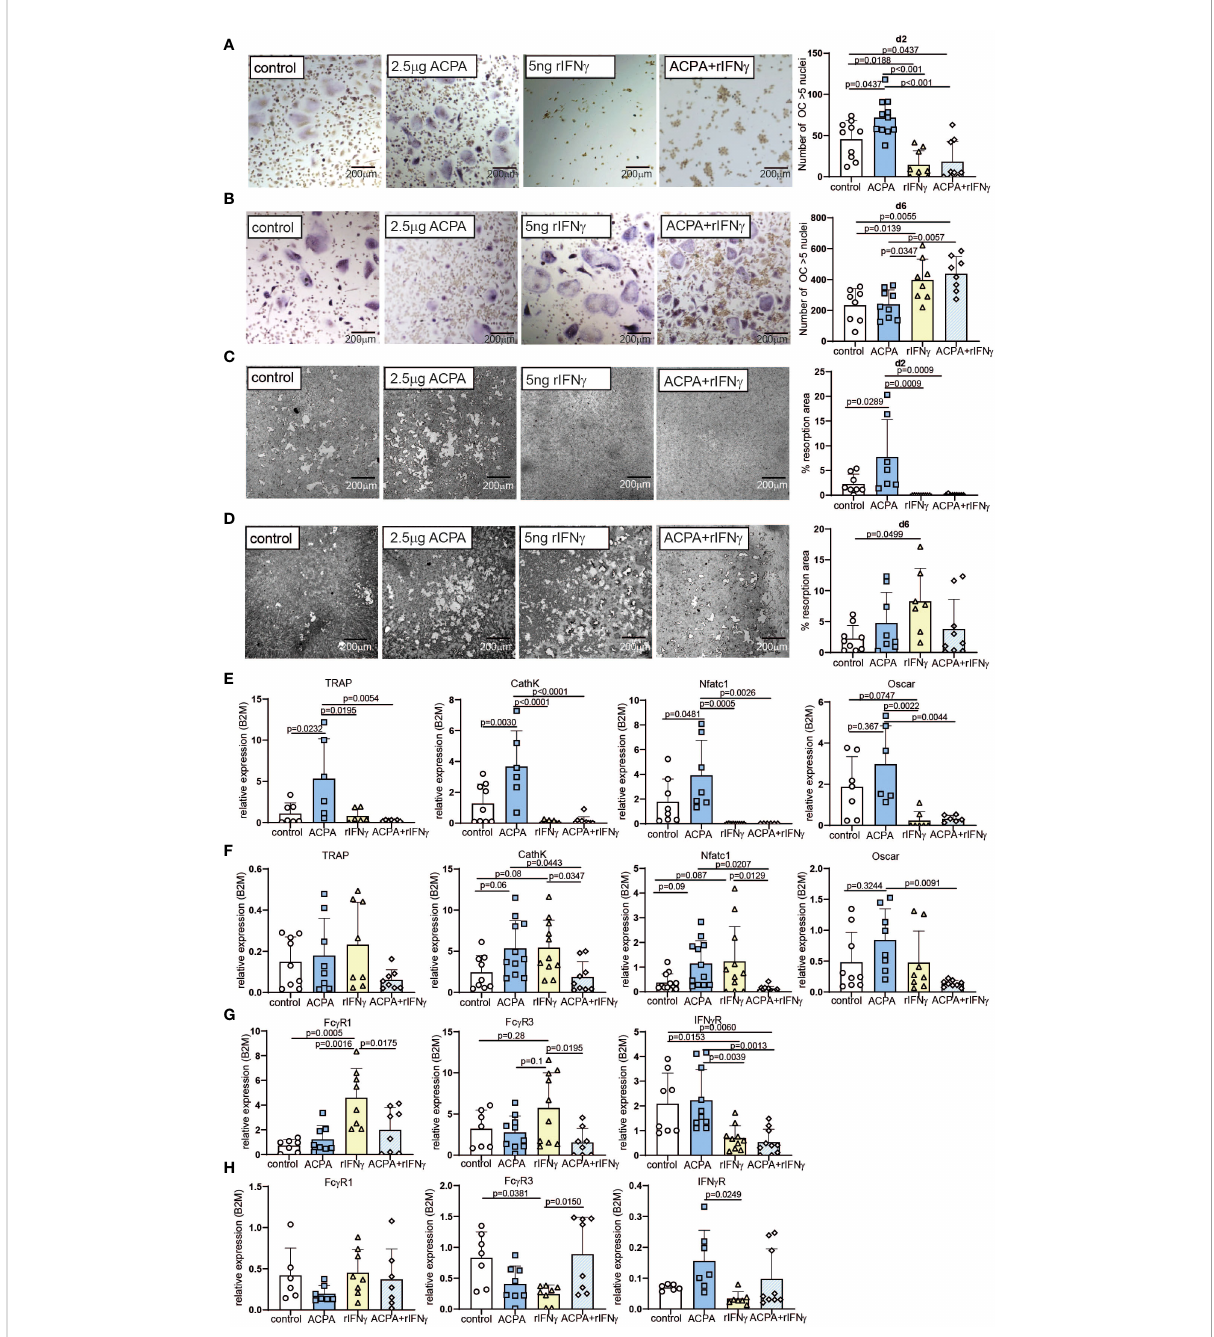
FIGURE 2 Varying effects of Fc g R and IFN g R activation dependent on the stage of osteoclast differentiation. Representative tartrate-resistant acid phosphatase (TRAP) staining (left) and the numbers (right) of in-vitro differentiated human peripheral blood mononuclear cells (PBMCs) by M-CSF and RANKL (control) supplemented with 2.5 µg of antibodies against citrullinated proteins (ACPA) or 5 ng of IFN g at day 2 (A) or at day 6 (B) . Representative resorption pits (left) and percentage of resorbed area (right) of in-vitro differentiated human PBMCs by M-CSF and RANKL (control) supplemented with 2.5 µg of ACPA or 5 ng of IFN g at day 2 (C) or at day 6 (D) . Real-time expression analyses of indicated osteoclast marker (E) and Fc g R1, Fc g R3, and IFN g R (F) in response to stimulation with 2.5 µg of ACPA or 5 ng of IFN g at day 2, and real-time expression analyses of indicated osteoclast marker (G) and Fc g R1, Fc g R3, and IFN g R (H) in response to stimulation with 2.5 µg of ACPA or 5 ng of IFN g at day 6 compared to M-CSF- and RANKL-stimulated controls. Data are the mean − /+ s.d. One-way ANOVA was used for the analysis, and the corresponding p -values are indicated in the fi